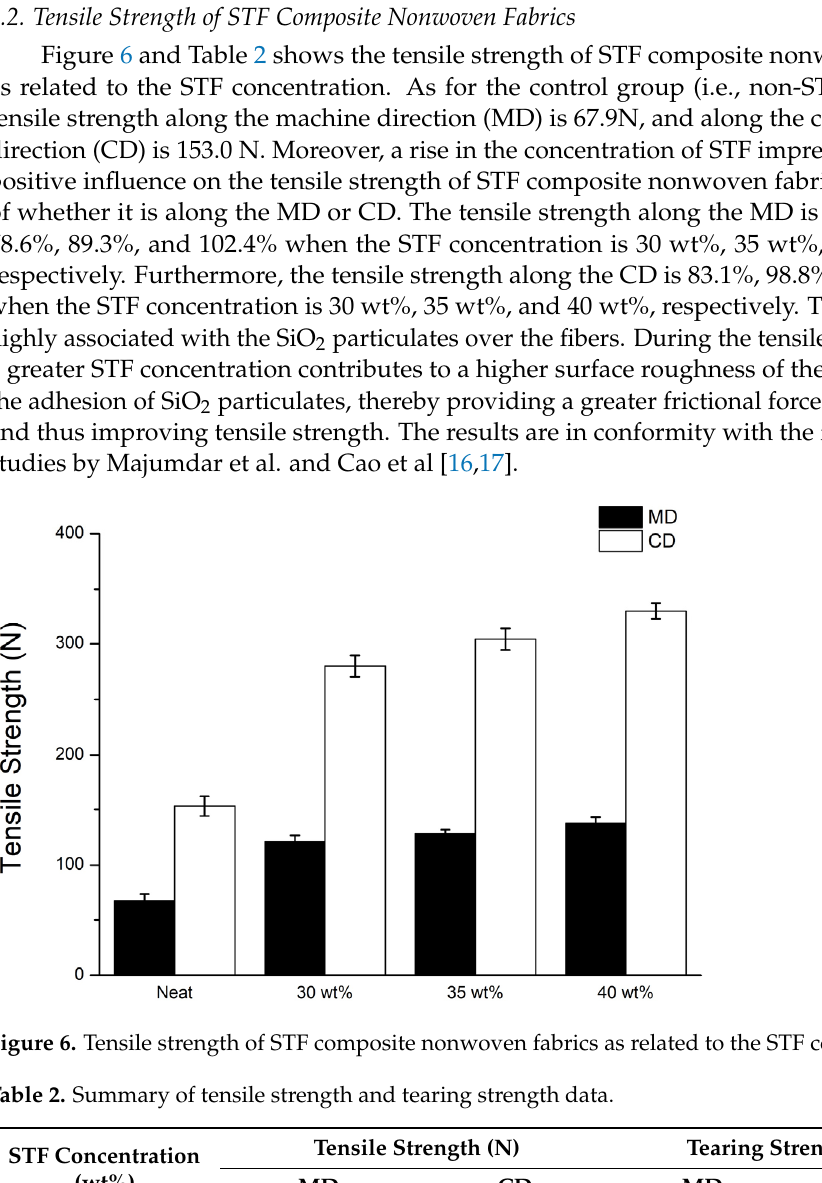
Figure 5. SEM images of ( a ) control group; and STF-saturated composite nonwoven fabrics as re- lated to the STF concentration, being: ( b ) 30 wt%.; ( c ) 35 wt%.; ( d ) 40 wt%.